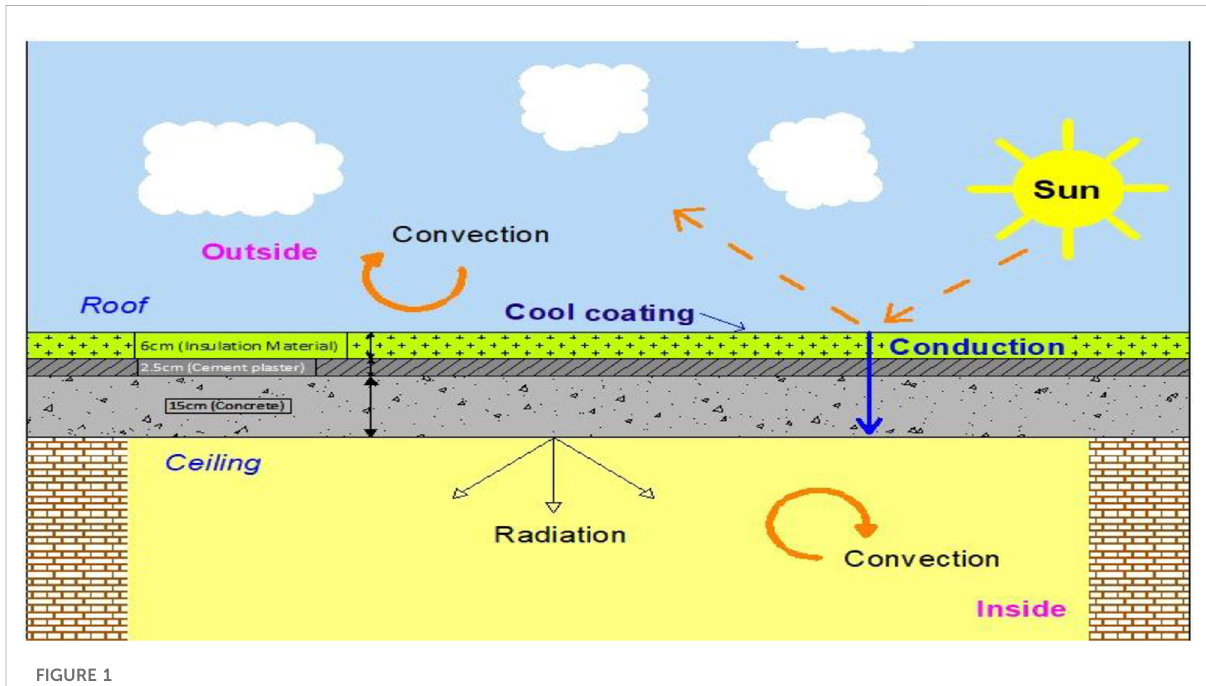
FIGURE 1 Schematic illustration of conduction process on a fl at rooftop (source: author ’ s